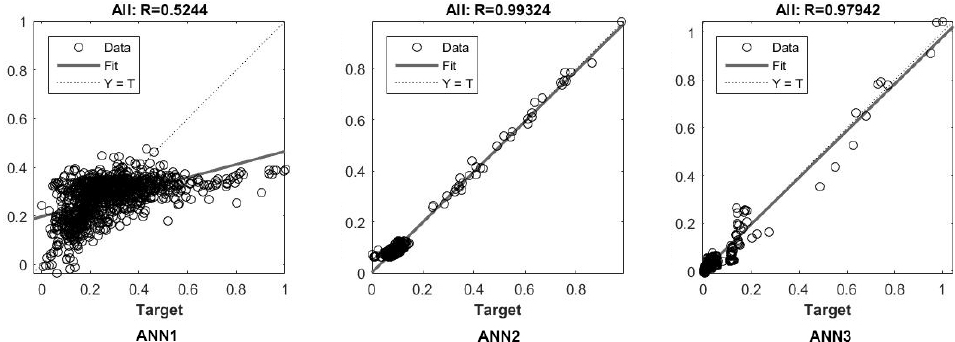
Table 3. Results of the three neural networks.